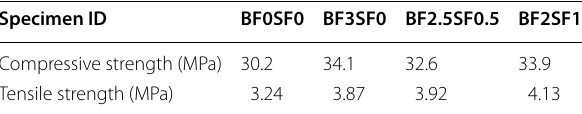
compressive and tensile strengths of various